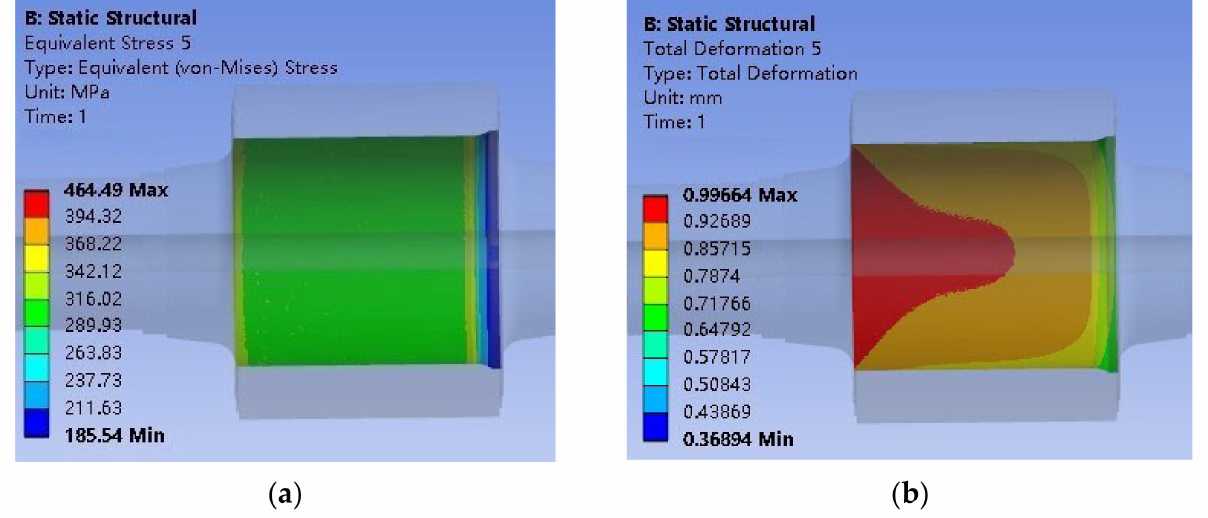
Figure 19. Simulation nephograms of optimized roller sleeve: ( a ) equivalent stress nephogram; ( b ) deformation nephogram.